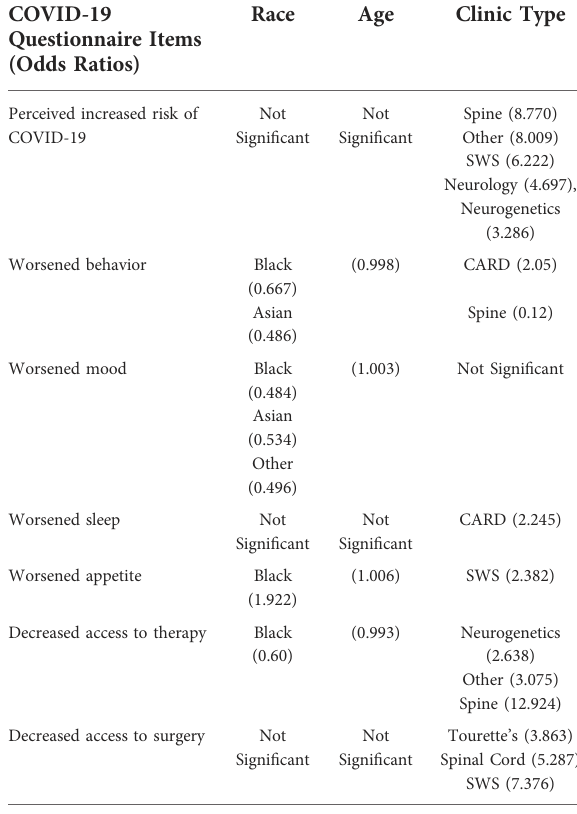
Questionnaire responses. COVID-19